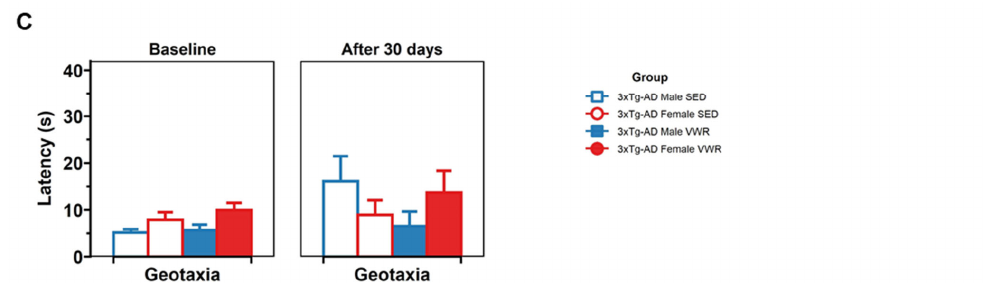
Figure 5. Sensorimotor assessment. ( A ) Muscular strength at baseline and after 30 days. ( B ) Muscular endurance at baseline and after 30 days. ( C ) Geotaxia at baseline and after 30 days. Factorial analysis: